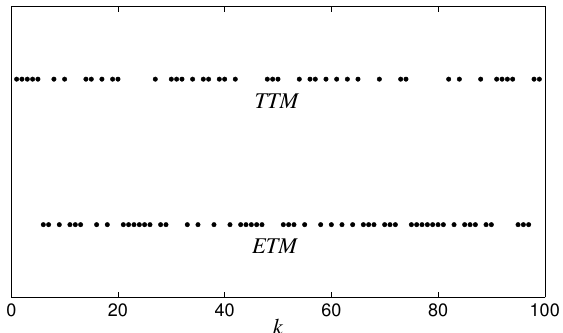
Figure 3. Switch times of the